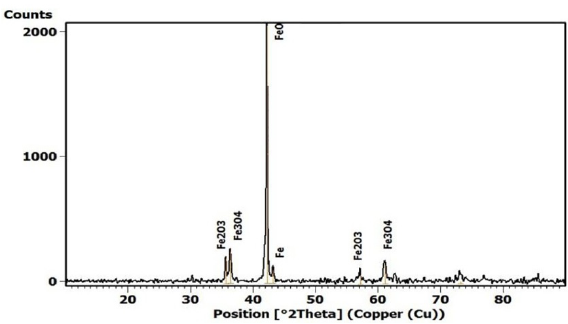
Figure 4. X ‐ ray diffraction (XRD) results of oxide scale for Steel 1.